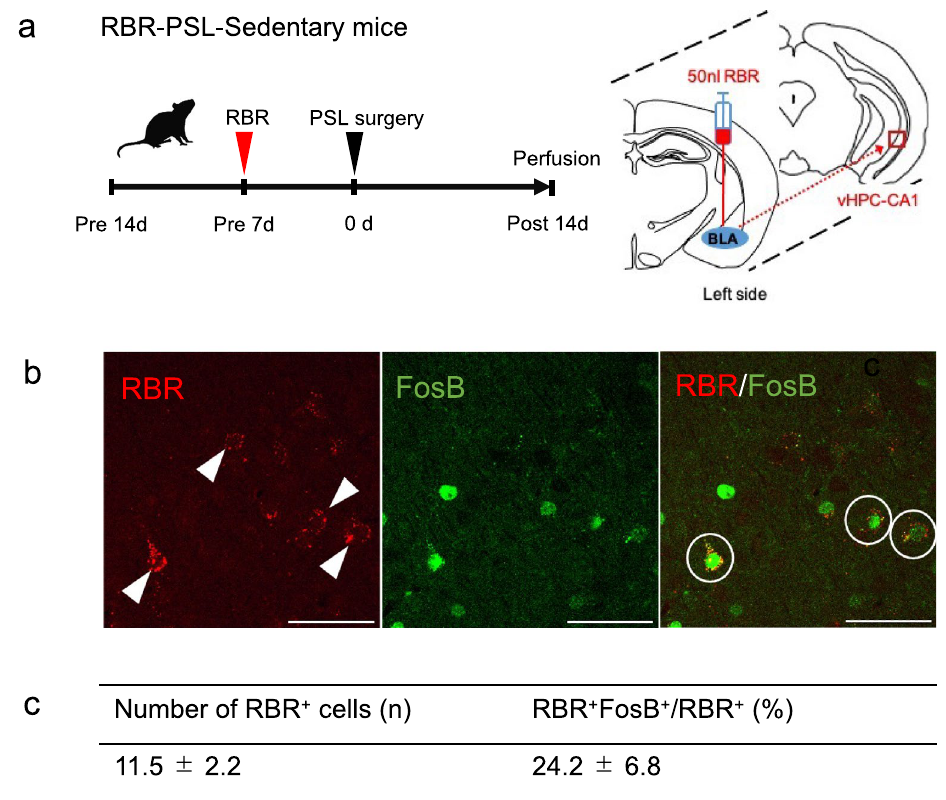
Figure 7. Activation of neurons projecting from the vHPC-CA1 to the BLA in PSL-sedentary mice. ( a ) Protocol for the retrograde tracer experiment. PSL-sedentary mice were injected with 50 nl of RBR into the left side of the BLA one week before PSL surgery. At 2 weeks later PSL surgery, mice were perfused and analyzed with double-immunostaining (n = 5). ( b ) Photomicrographs showing RBR (red) positive signals and FosB (green) immunoreactivities in the vHPC-CA1. Arrowheads indicate neurons (RBR + cells) projecting from the vHPC to the BLA (left panel). Activated neurons (RBR + FosB + cells) projecting from the vHPC to the BLA are marked by the circles in the right panel. Scale bars = 50 μm. ( c ) A table showing the quantitative results of activated neurons (RBR + FosB + cells) projecting from the vHPC to the BLA in PSL-Sedentary mice. Quantitative data are presented as mean ± SEM. PSL partial sciatic nerve ligation, vHPC ventral hippocampus, BLA basolateral amygdala, RBR Retrobeads